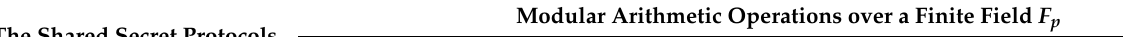
Table 5. The computation cost of shares generation for the proposed protocol and some linear shared secret protocols.